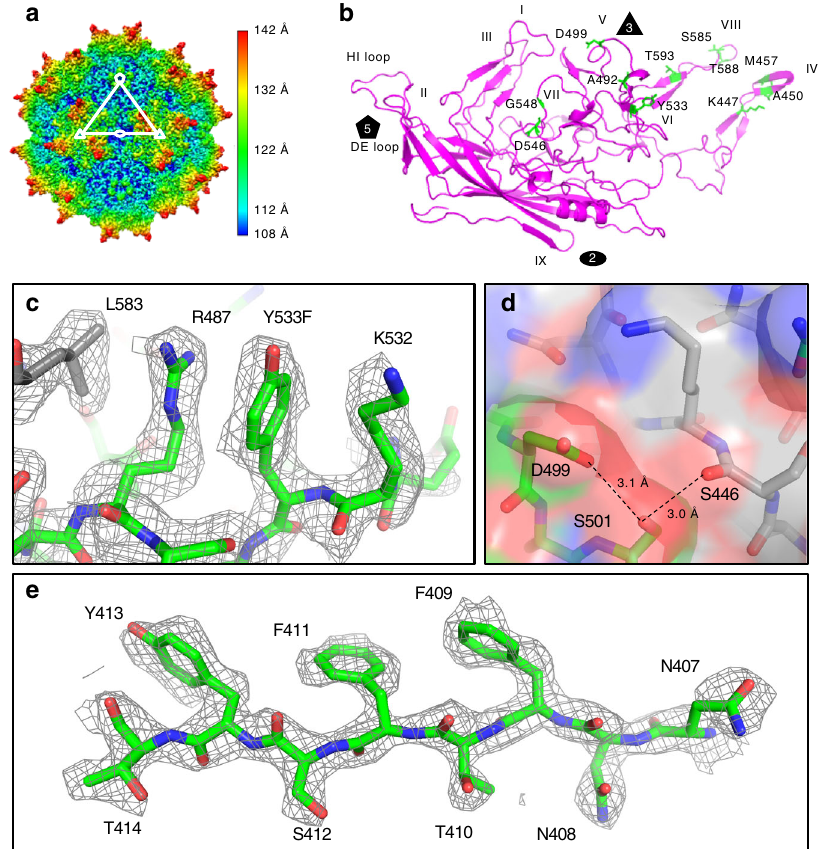
Fig. 5 Cryo-EM primary metrics, map reconstruction, and model generation of AAVv66. a Density map of AAVv66. Color scheme demarcates the topological distance from the center (Å). b Ribbon structure of the re fi ned AAVv66 capsid monomer. Amino acids differing from AAV2 are highlighted in green. The twofold (oval), threefold (triangle), and fi vefold (pentagon) symmetries are annotated. Part of AAVv66 electron density (dark grey mesh) and residues (green for one monomer and grey for neighboring monomers) are shown for regions close to c L583, R487, Y533, and K532, d S446, D499, and S501, and e